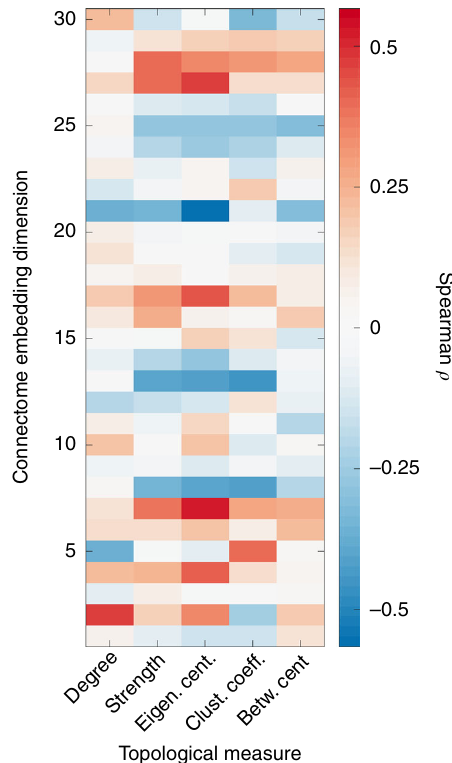
Fig. 7 Correlations between CE dimensions and standard topological measures. The eigenvector centrality showed the highest magnitude of correlation to only two of the CE dimensions (maximum Spearman correlation of ρ = 0.51, p < 10 − 10 and minimum correlation of ρ = − 0.57, p < 10 − 10 ). Nevertheless, generally the correlation values between the CE elements and the graph theoretical measures were low and followed no obvious, meaningful